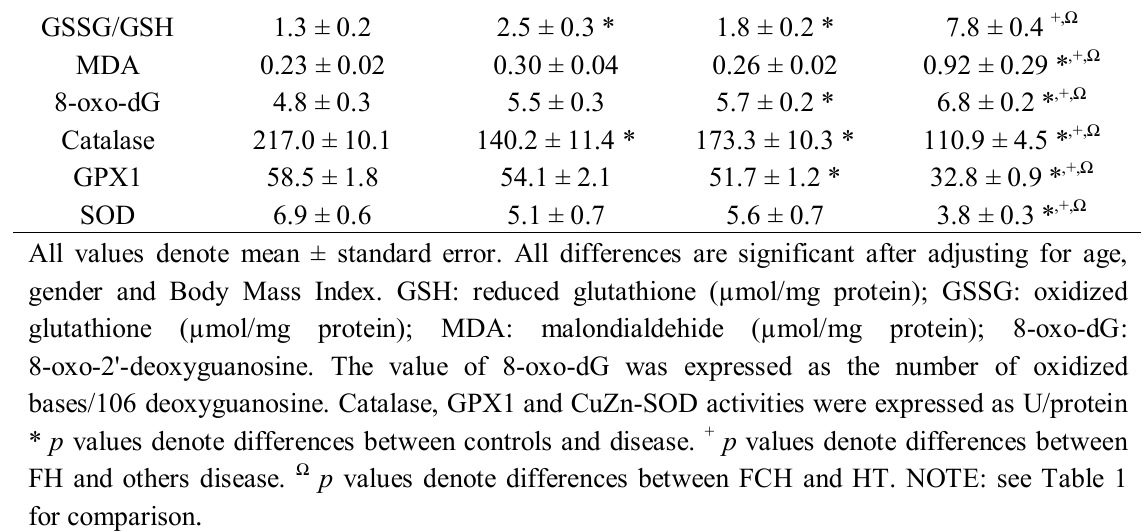
Table 2. Oxidative stress, byproducts and antioxidant enzymes activity in the study. Variables